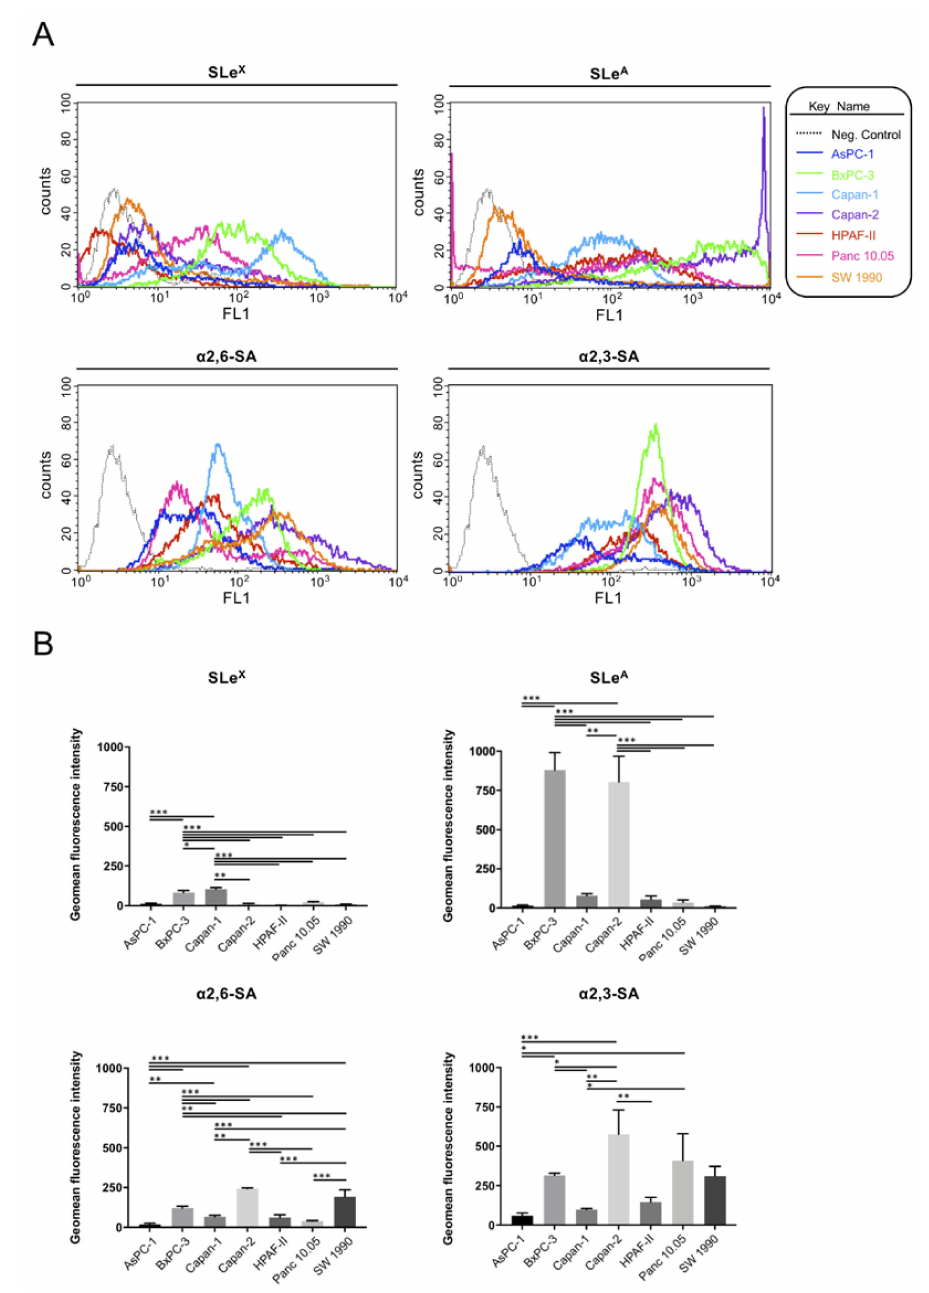
Figure 1. Analysis of the cell surface glycan structures in pancreatic ductal adenocarcinoma (PDA) cell lines by flow cytometry. ( A ): Overlay of the representative cytometry histograms of the di ff erent glycan structures of the seven PDA cell lines: sialyl-Lewis x (top left), sialyl-Lewis a (top right), α 2,6-sialic acid (bottom left) and α 2,3-sialic acid (bottom right). Color legend: Negative control is represented with a continuous dot line: ( ... ), AsPC-1 (dark blue line), BxPC-3 (green line) Capan-1 (light blue line), Capan-2 (purple line), HPAF-II (red line), Panc 10.05 (pink line) and SW 1990 (orange line). ( B ): Geomean fluorescence intensity of the di ff erent glycan structures of the seven PDA cell lines: sialyl-Lewis x (top left), sialyl-Lewis a (top right), α 2,6-sialic acid (bottom left) and α 2,3-sialic acid (bottom right). Data represent mean ± SD from three independent experiments, except for Capan-2, HPAF-II, Panc 10.05 and SW 1990, in which two values were used. ANOVA and Tukey’s multiple comparison post-hoc test was performed. p < 0.05: *; p < 0.01: ** and p <